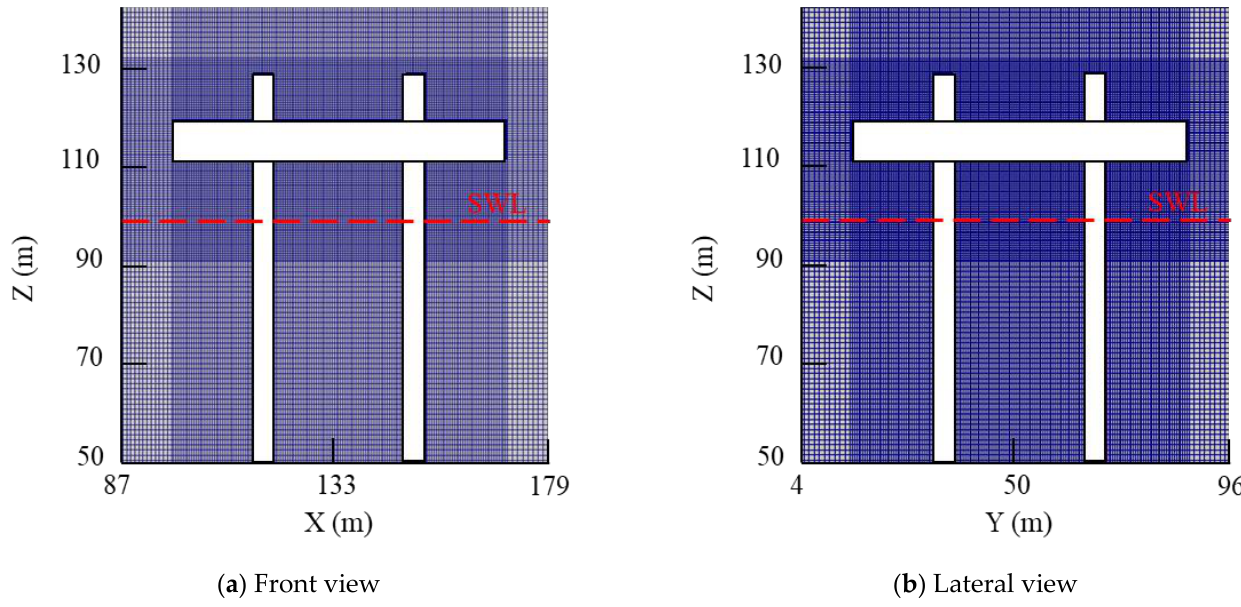
Figure 2. Generated mesh in the wave model around the jack-up offshore platform. Table 1. Setting of grid size in the wave model.